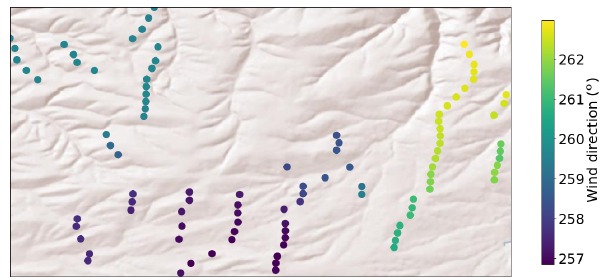
Figure 8. The consensus-based wind direction is shown across part of the wind farm based on the color of each turbine with the terrain plotted in the background. This shows the effects of terrain on the wind direction and indicates that the wind direction can vary across the wind